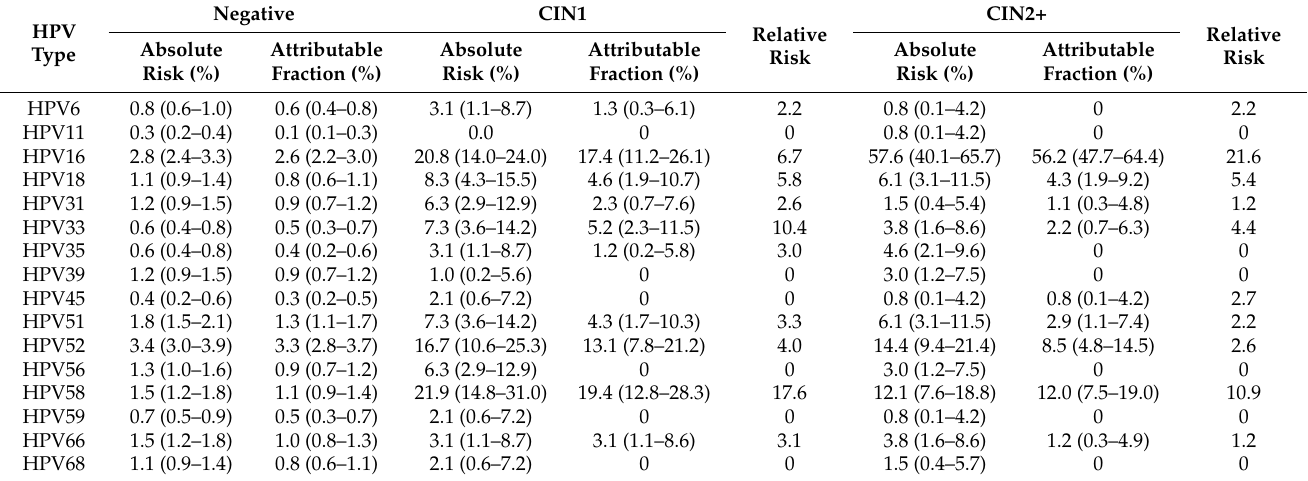
Table 3. The absolute risk and attributable proportion of different HPV types by